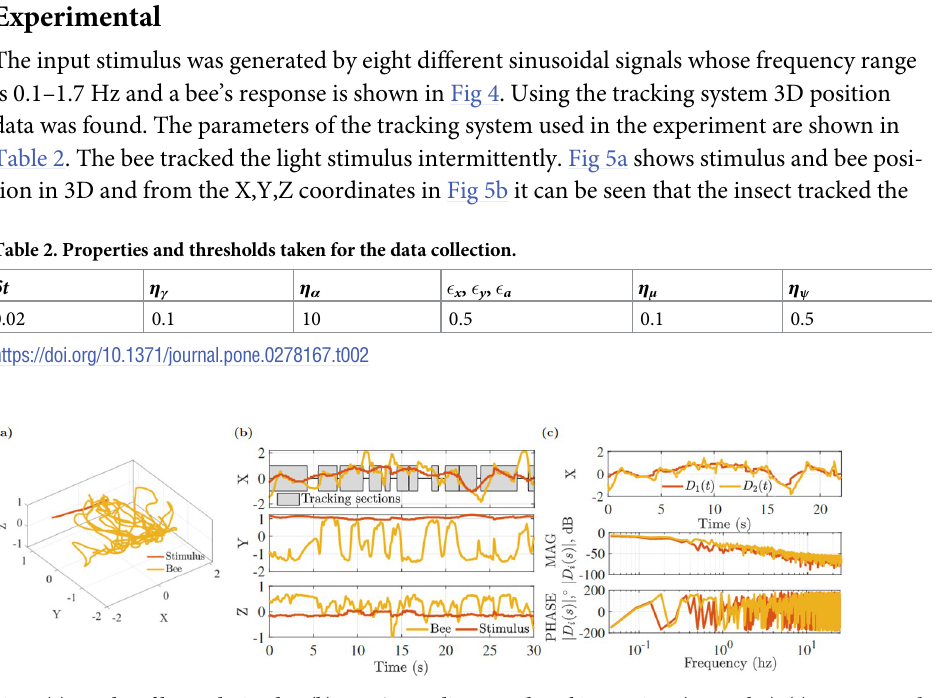
Fig 5. (a) 3D plot of bee and stimulus, (b) X, Y, Z coordinates and tracking sections (gray color), (c) concatenated trajectories, magnitude and phase of D i , i = 1,